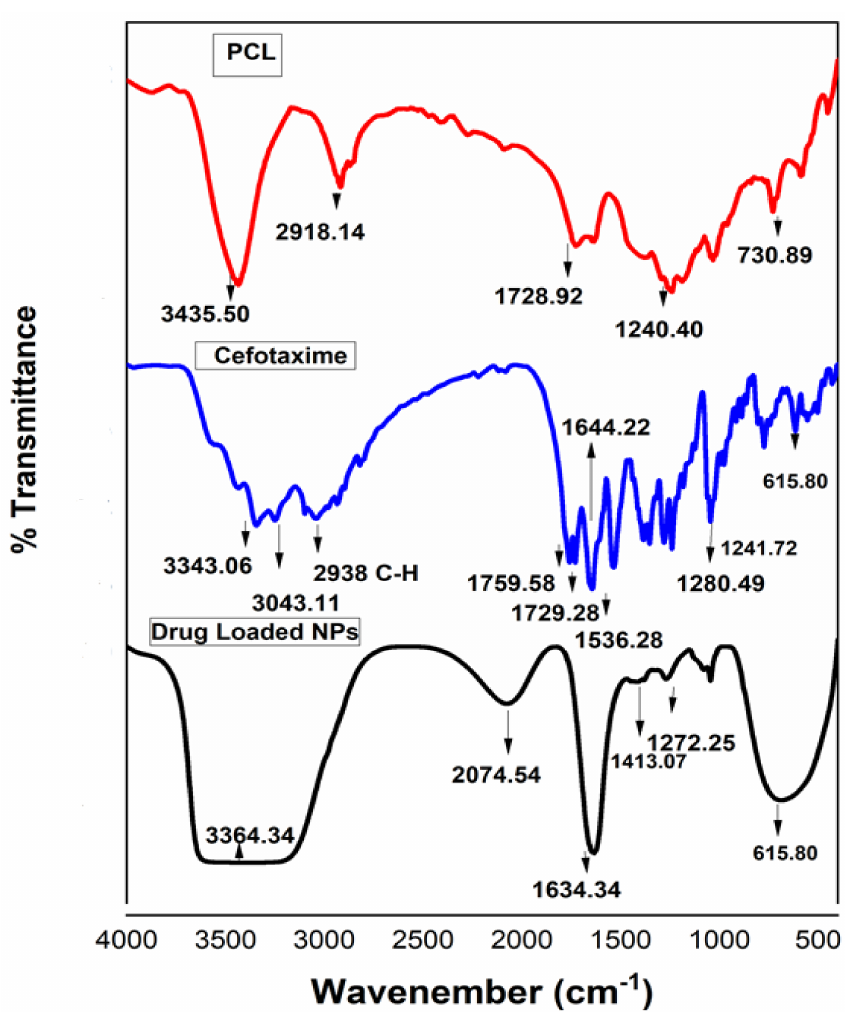
Figure 3. Fourier transform infrared (FTIR) analysis of polycaprolactone, cefotaxime and drug-loaded polymeric NPs.